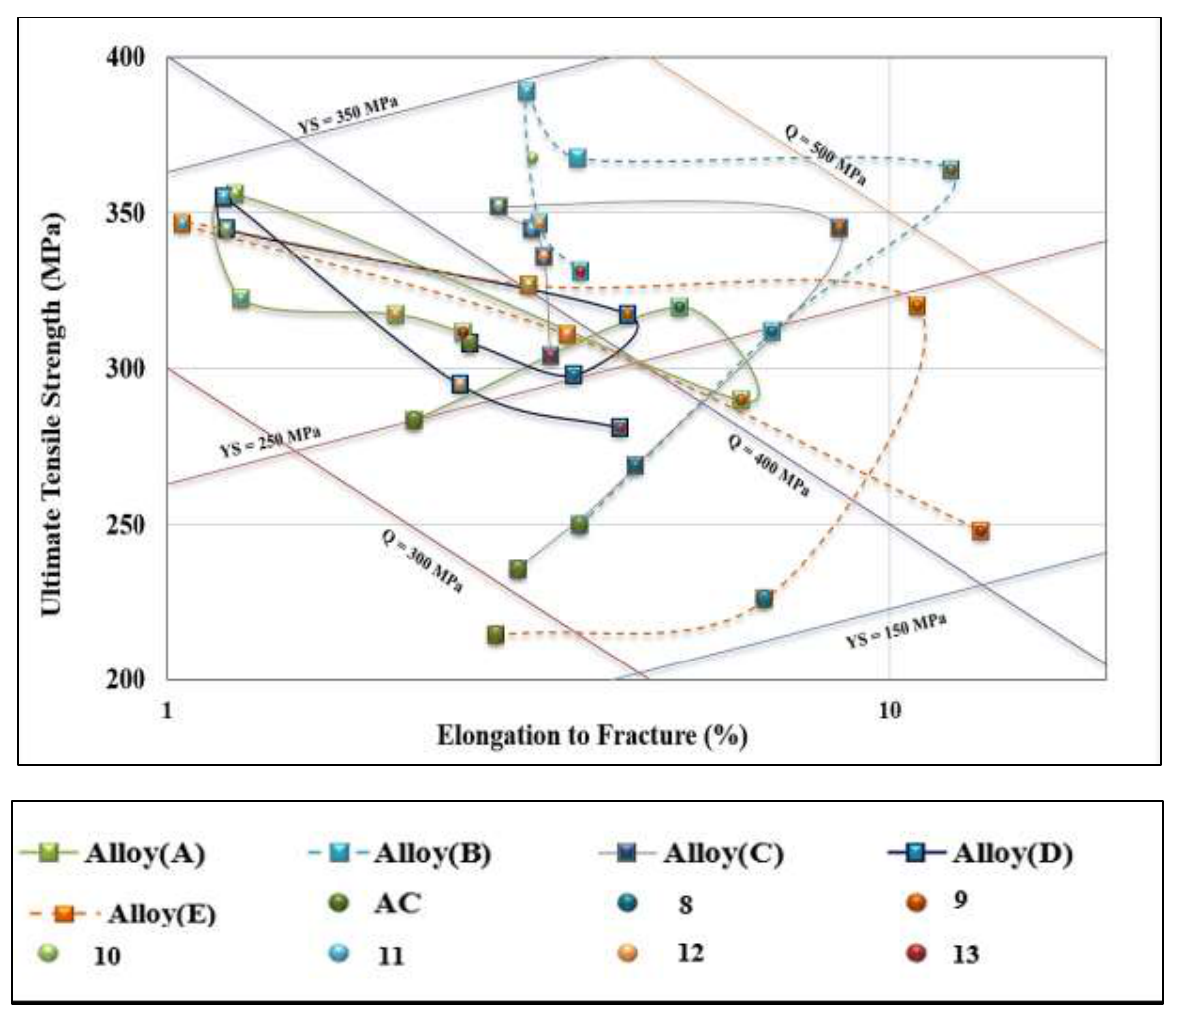
Figure 12. Quality chart showing the relationship between UTS and %El for the D and E alloys investigated in the as-cast and six heat treatment conditions (with SHT for 8 h). Although alloy B produced a Q value falling between alloys A and C, its corresponding PYS value is the highest among the three alloys. Thus, application of the T6 temper to alloy B may represent the optimum conditions for using alloy T200. Alloy B also showed higher values for both heat treatment conditions both without and with aging than the reference alloys D and E. In general, both alloys B and E exhibited a wide range of Q and PYS values compared to alloy D that represented the shortest cycle. It can be concluded, therefore, that alloy B in the T6 condition provides the optimum alloy composition/heat treatment condition for achieving the best tensile properties and alloy quality for the T200 alloy at room temperature. On the other hand, alloy E (broken red line) revealed the widest